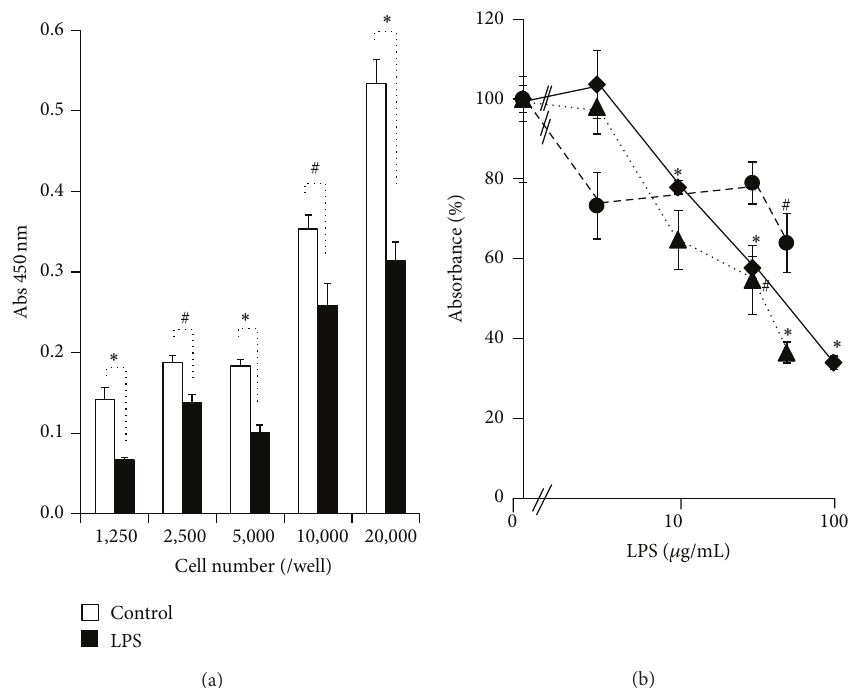
Figure 3: Effect of LPS on BrdU incorporation in AEC. (a) AEC were seeded in 96-well microplates at densities of 1,250, 2,500, 5,000, 10,000, and 20,000 cells per well in 200 𝜇 L of DME/Ham’s F12 medium supplemented with 10% FBS, 100 𝜇 g/mL streptomycin, and 0.5 𝜇 g/mL amphotericin B. Either LPS (10 𝜇 g/mL) or vehicle (control) was added to each well. After 96h of culture, BrdU incorporation was studied. The results from the quadruplicate assay are shown as the mean ± SE ( 𝑛 = 4 ). # 𝑃 < 0.05 compared with the control value at each cell density. ∗ 𝑃 < 0.01 compared with the control value at each cell density. (b) Fetal membranes were obtained from three patients. AEC from each patient were cultured independently in DME/Ham’s 12 medium supplemented with 10%FBS, 100 𝜇 g/mL streptomycin, 0.5 𝜇 g/mL amphotericin B, andvariousconcentrationsofLPS.After96 hofculture,BrdUincorporationwasstudied.Closedcircles,closedrectangles,andclosedtriangles show AEC from each patient. The absorbance at AEC cultured without LPS is shown as 100%. The results from the quadruplicate assay are shown as the mean ± SE ( 𝑛 = 4 ). # 𝑃 < 0.05 compared with the control (LPS; 0ng/mL) value. ∗ 𝑃 < 0.01 compared with the control (LPS; 0ng/mL)